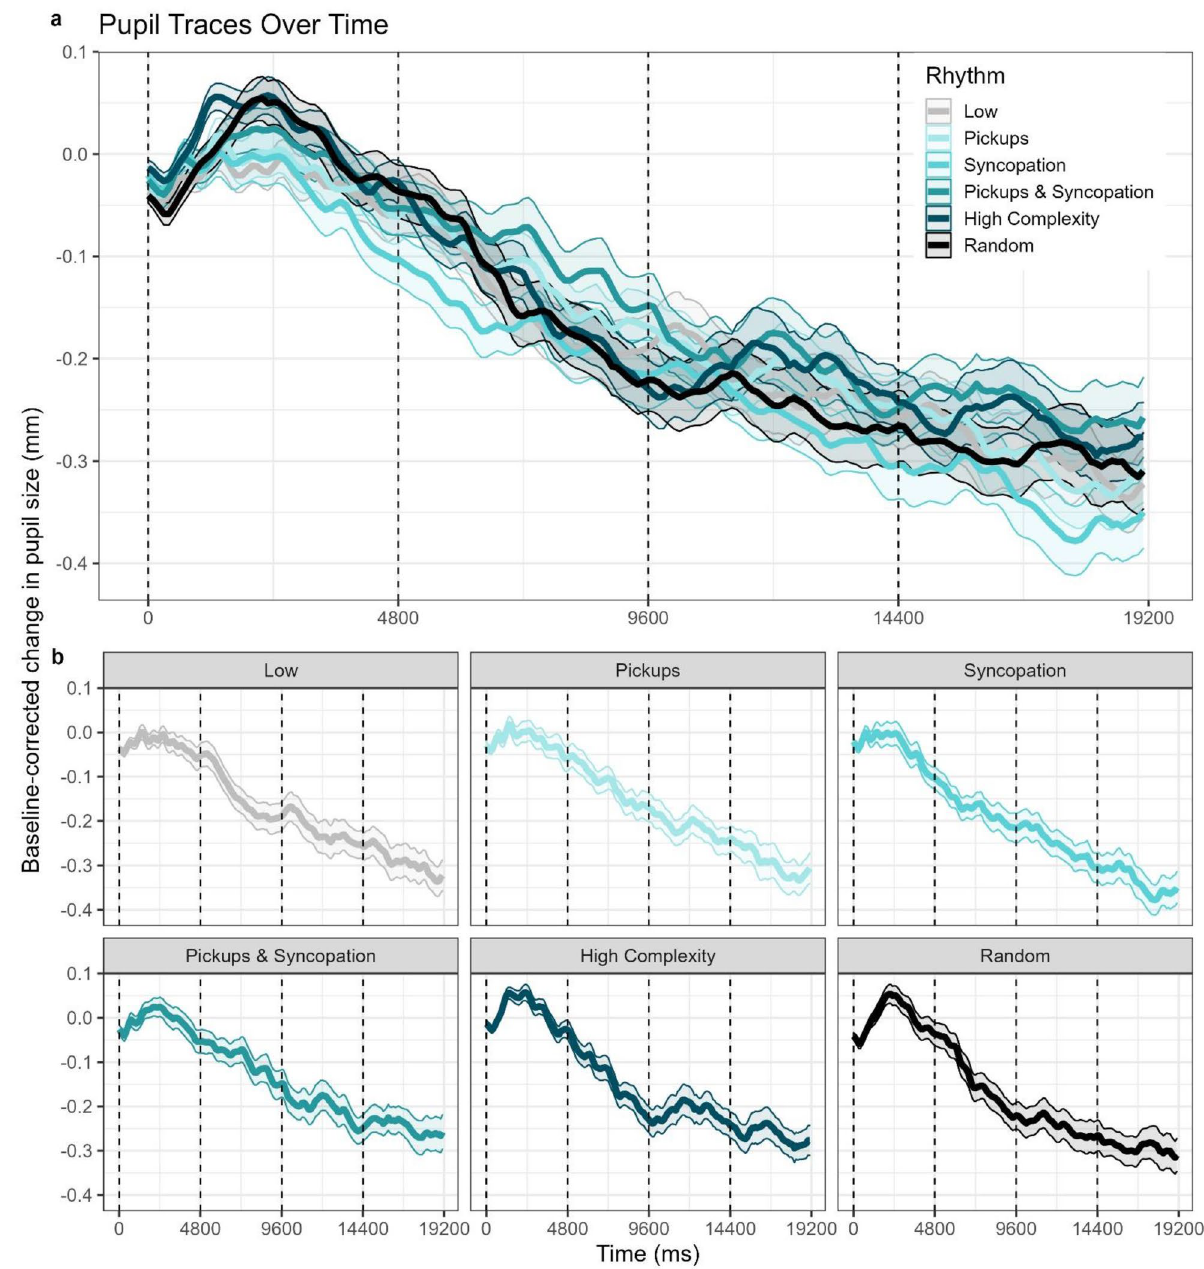
Figure 4. Pupil trace plots for all rhythm conditions over time. Ribbons represent within-subject 95% confidence intervals. Dashed vertical lines represent the boundaries where the first five rhythms looped. ( A ) Pupil traces for all rhythm conditions plotted against each other. ( B ) Pupil traces for each individual rhythm condition plotted separately for better